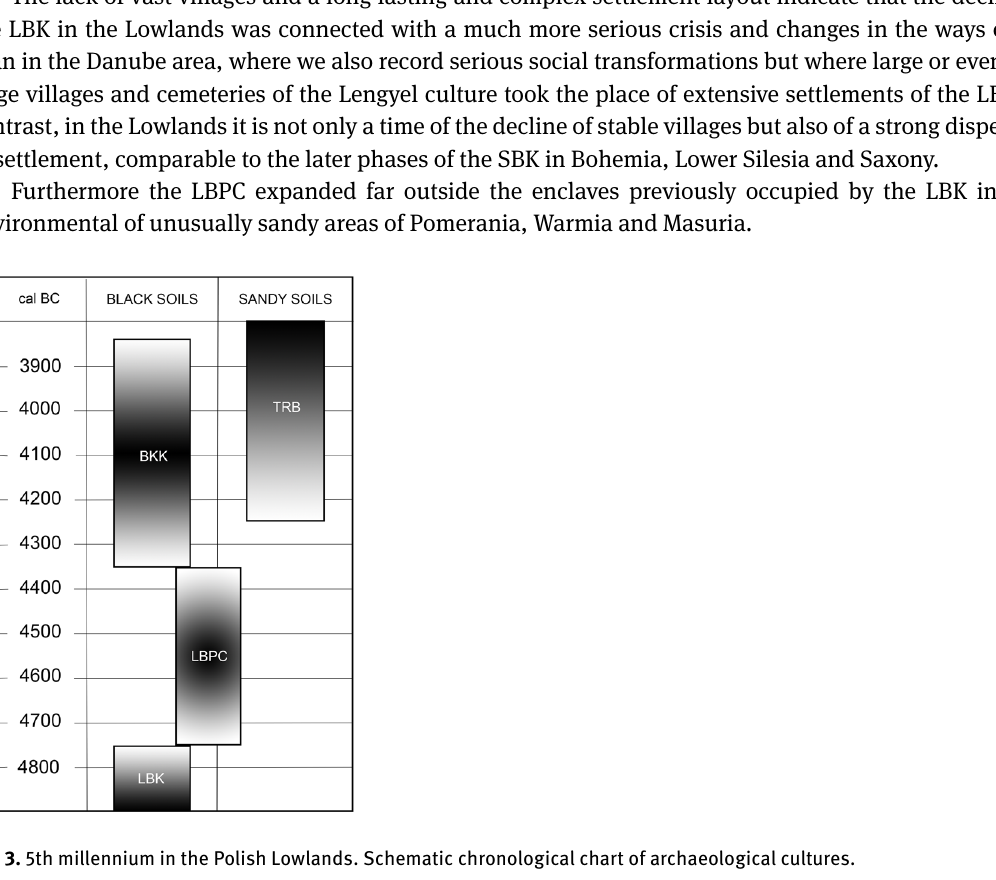
Fig. 3. 5th millennium in the Polish Lowlands. Schematic chronological chart of archaeological